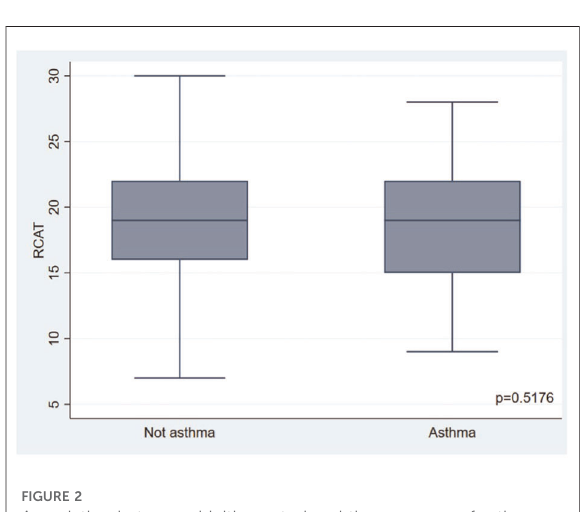
FIGURE 2 Association between rhinitis control and the presence of asthma.